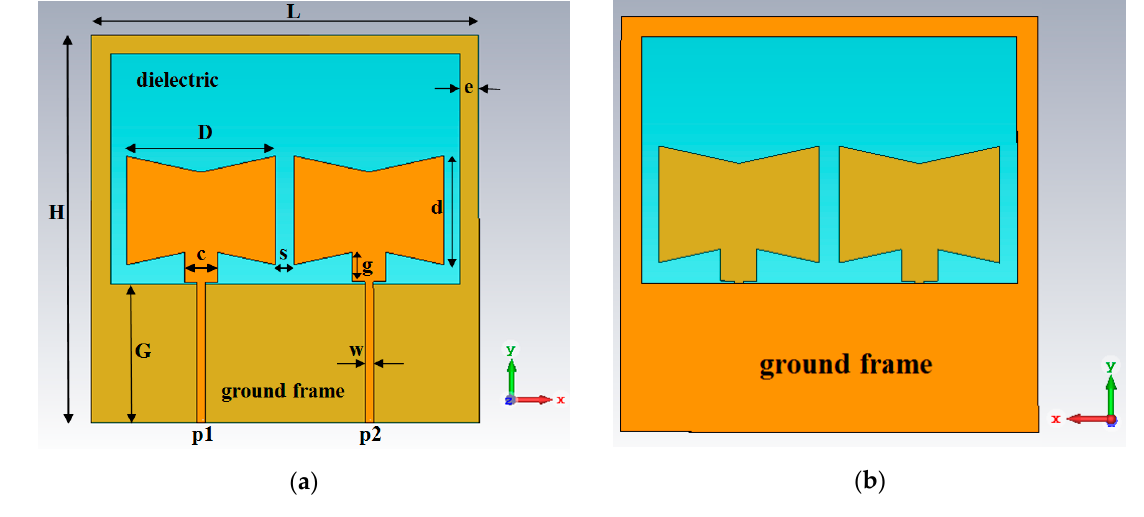
Figure 5. The layout of Antenna_2: ( a ) front side ( b ) back side. Table 2. Geometrical paremeter values of Antenna_2 in [mm].